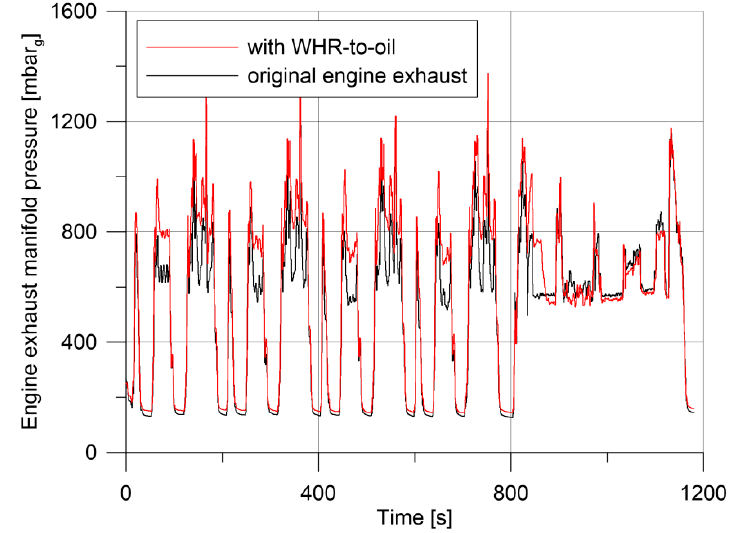
Figure 17. Exhaust gas pressure in the exhaust manifold (i.e., turbine inlet) in the two test cases performed.